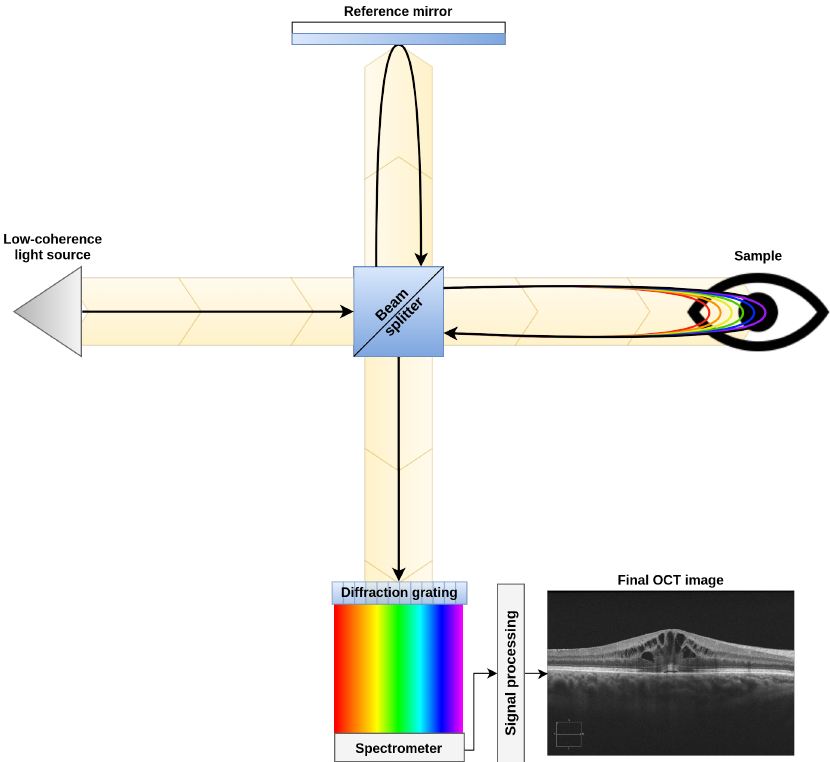
Figure 3. Diagram of a spectral domain optical coherence tomography